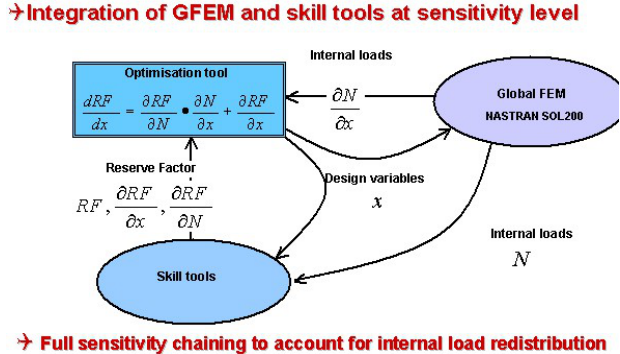
Fig. 11. Chain ruling of sensitivities inside COMBOX for a global-local optimization